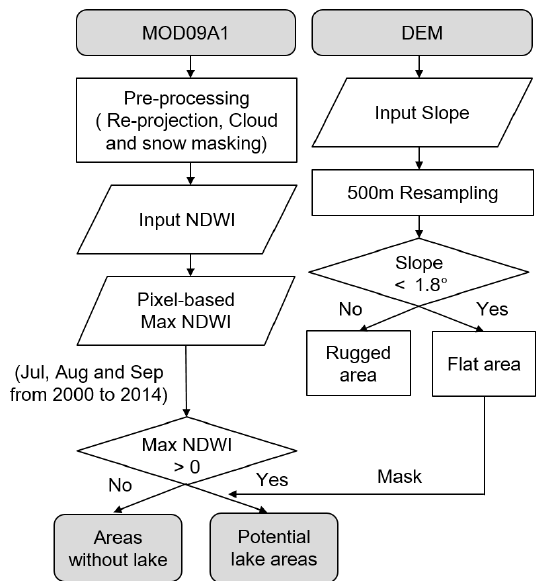
Figure 2. The identification method of potential dry lake beds based on Terra/MODIS and Digital Elevation Model (DEM).